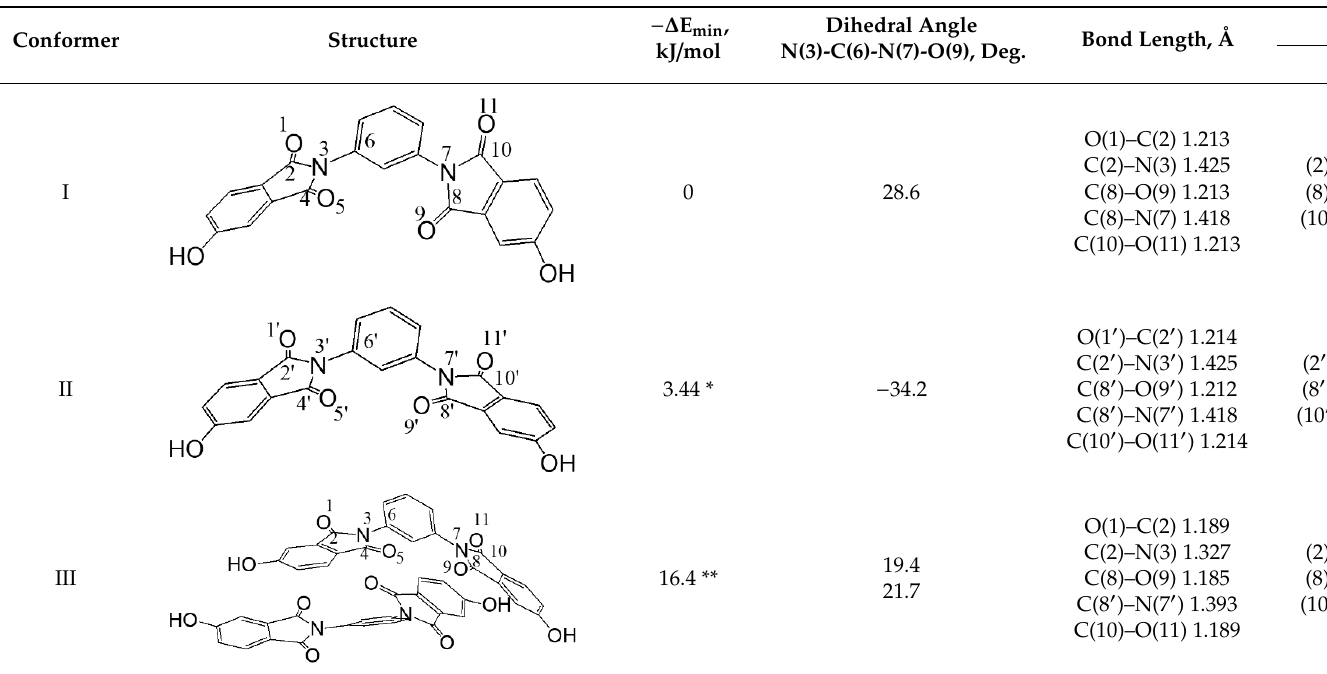
Table 2. Geometric and energy characteristics of two Im–Ph–Im’ fragment conformers.